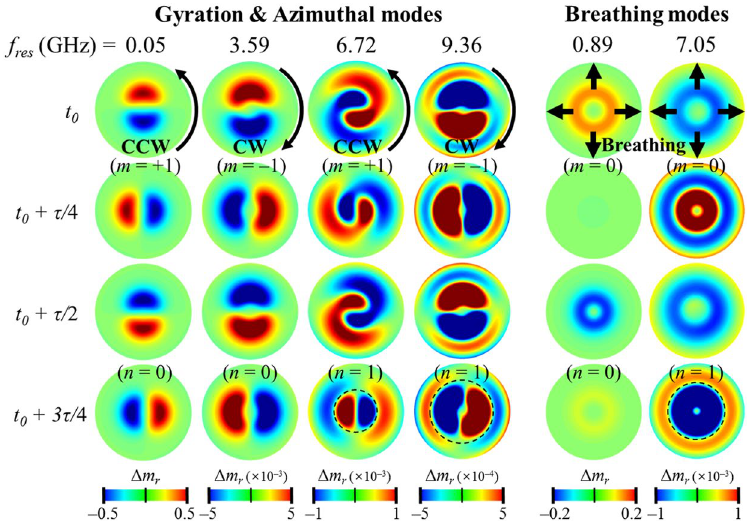
Figure 5. Characteristics of dynamic modes of skyrmion. Snapshot images of Δm r representative of dynamic eigenmodes of skyrmion: CCW (0.05, 6.72 GHz) and CW (3.59, 9.36 GHz) rotational modes as well as breathing mode (0.89, 7.05 GHz). The first to fourth rows indicate intervals of one-fourth time